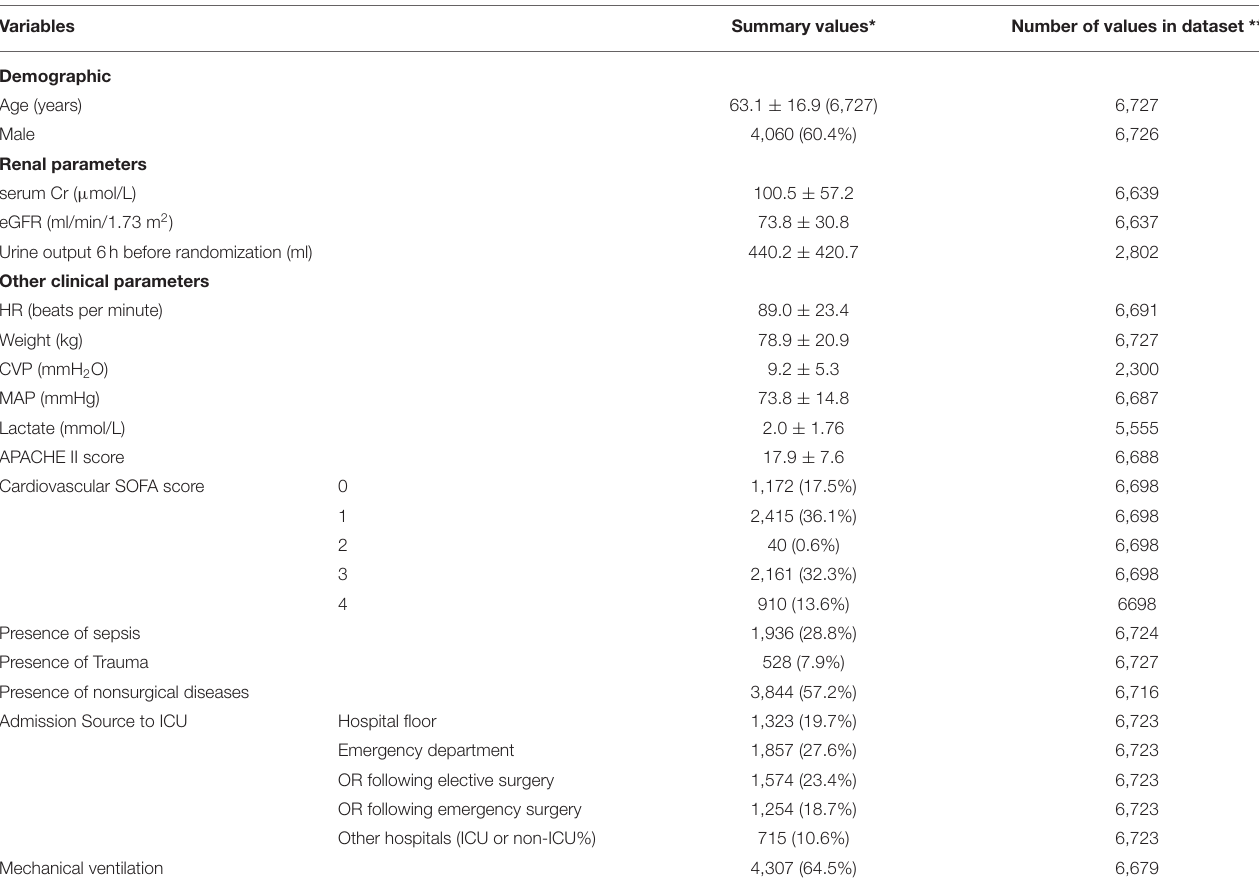
TABLE 1 | Baseline characteristics and the study outcome of the study